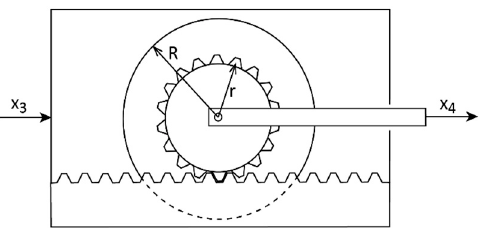
Figure 2. Fly wheel (without friction) as an ideal realization of an inerter. Table 5. Parameters of the fly wheel inerter